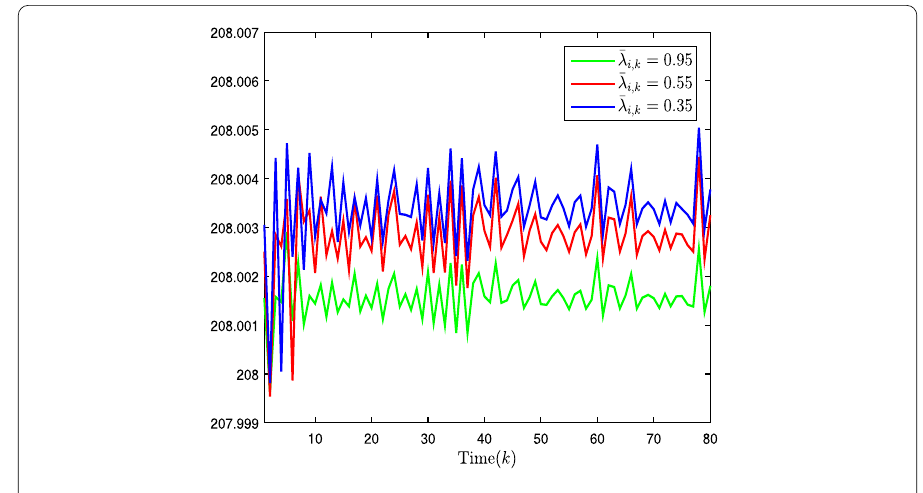
Figure 7 Upper bound with different ¯ λ i ,